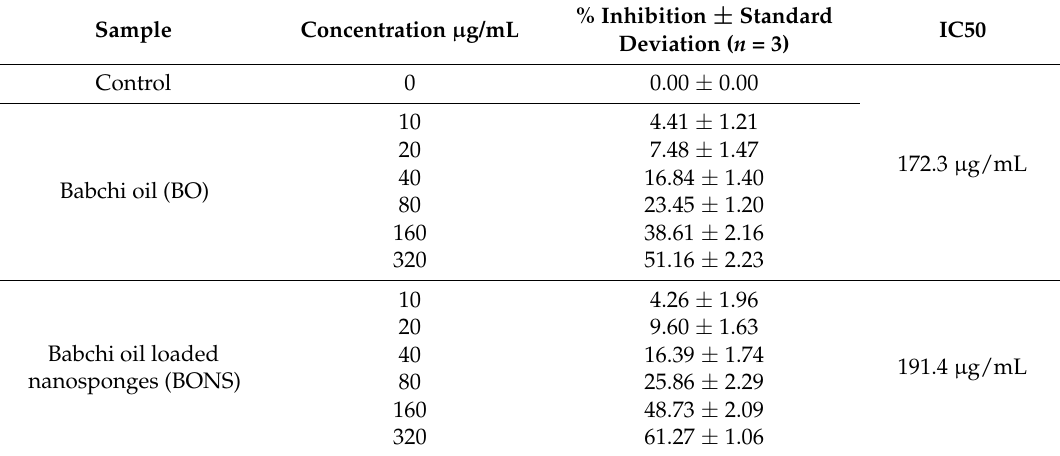
Table 5. Effect of BO and BONS on the viability of HaCaT cells as a function of drug concentration at 24 h.